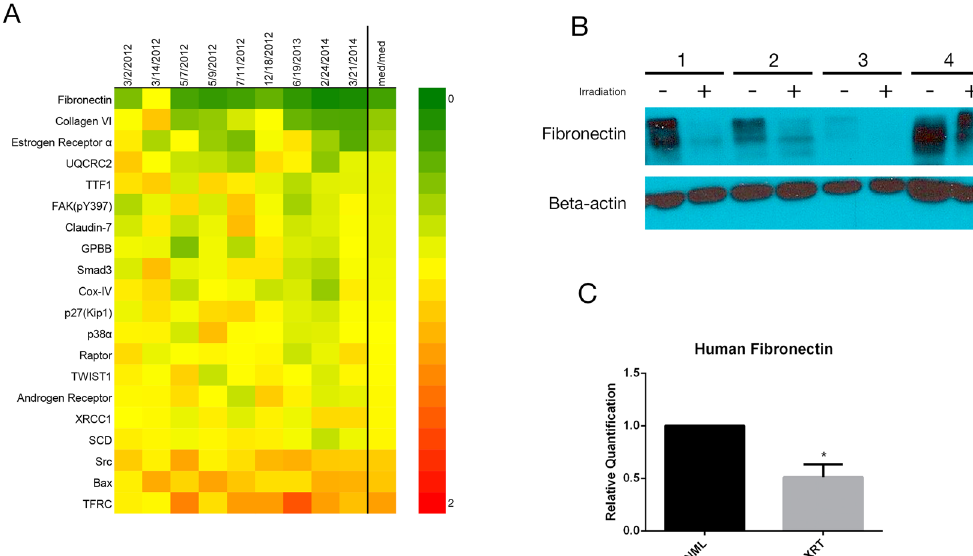
Figure 2. ( A ) Heat map of reverse phase protein array of paired irradiated and non-irradiated human skin samples. Samples are listed by date collected and labeled NML (normal) or XRT (radiated). Green corresponds to higher and red to lower relative expression. ( B ) Cropped Western blot of fibronectin expression in four pairs of human skin samples. ( C ) Relative quantification of fibronectin gene expression in paired human skin samples by